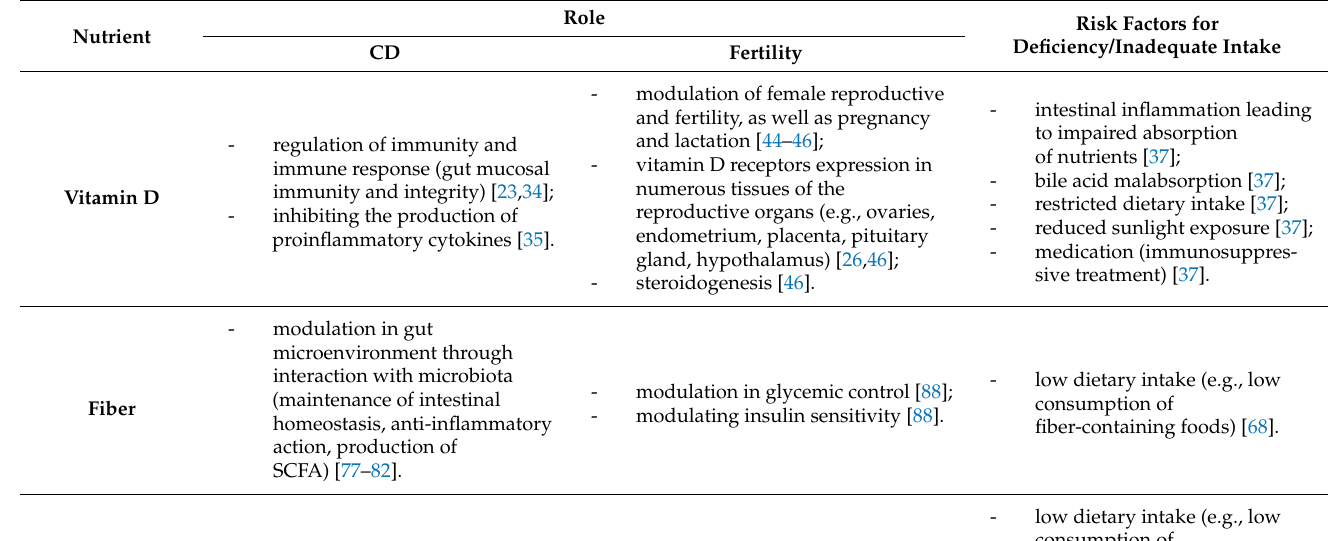
Table 1. The role of nutrients in CD and women